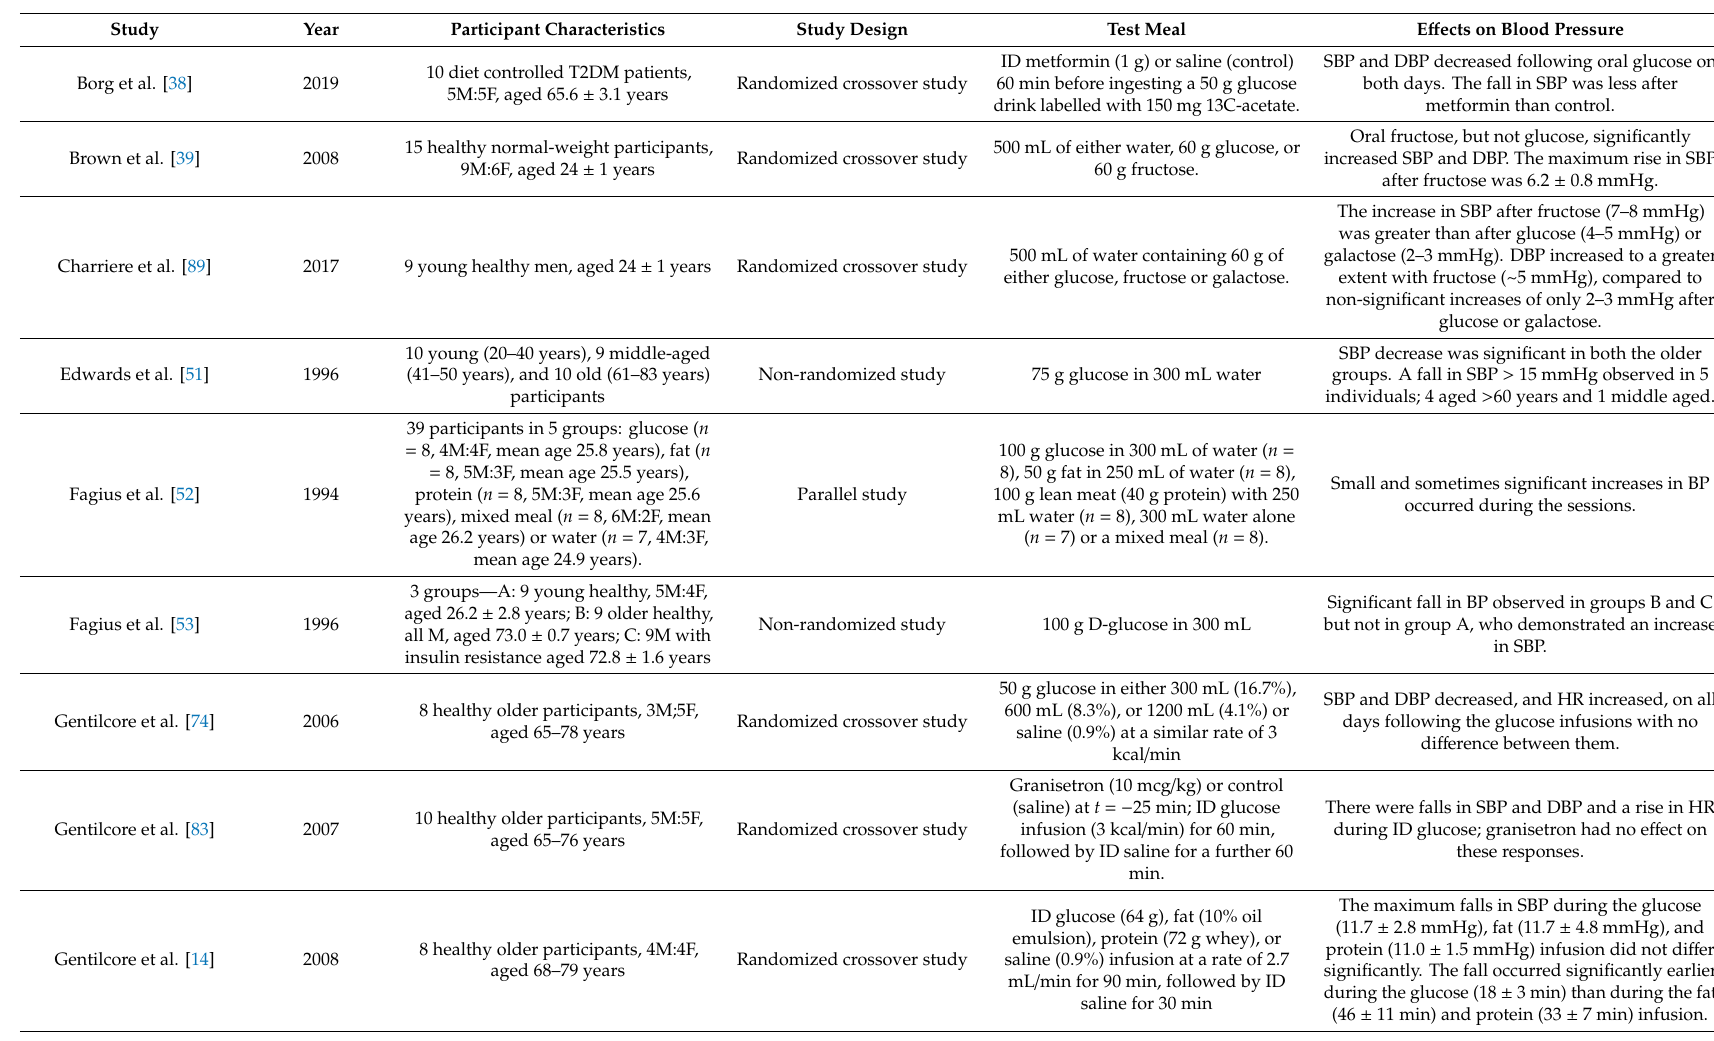
Table 1. Studies relating to the e ff ects of glucose on blood